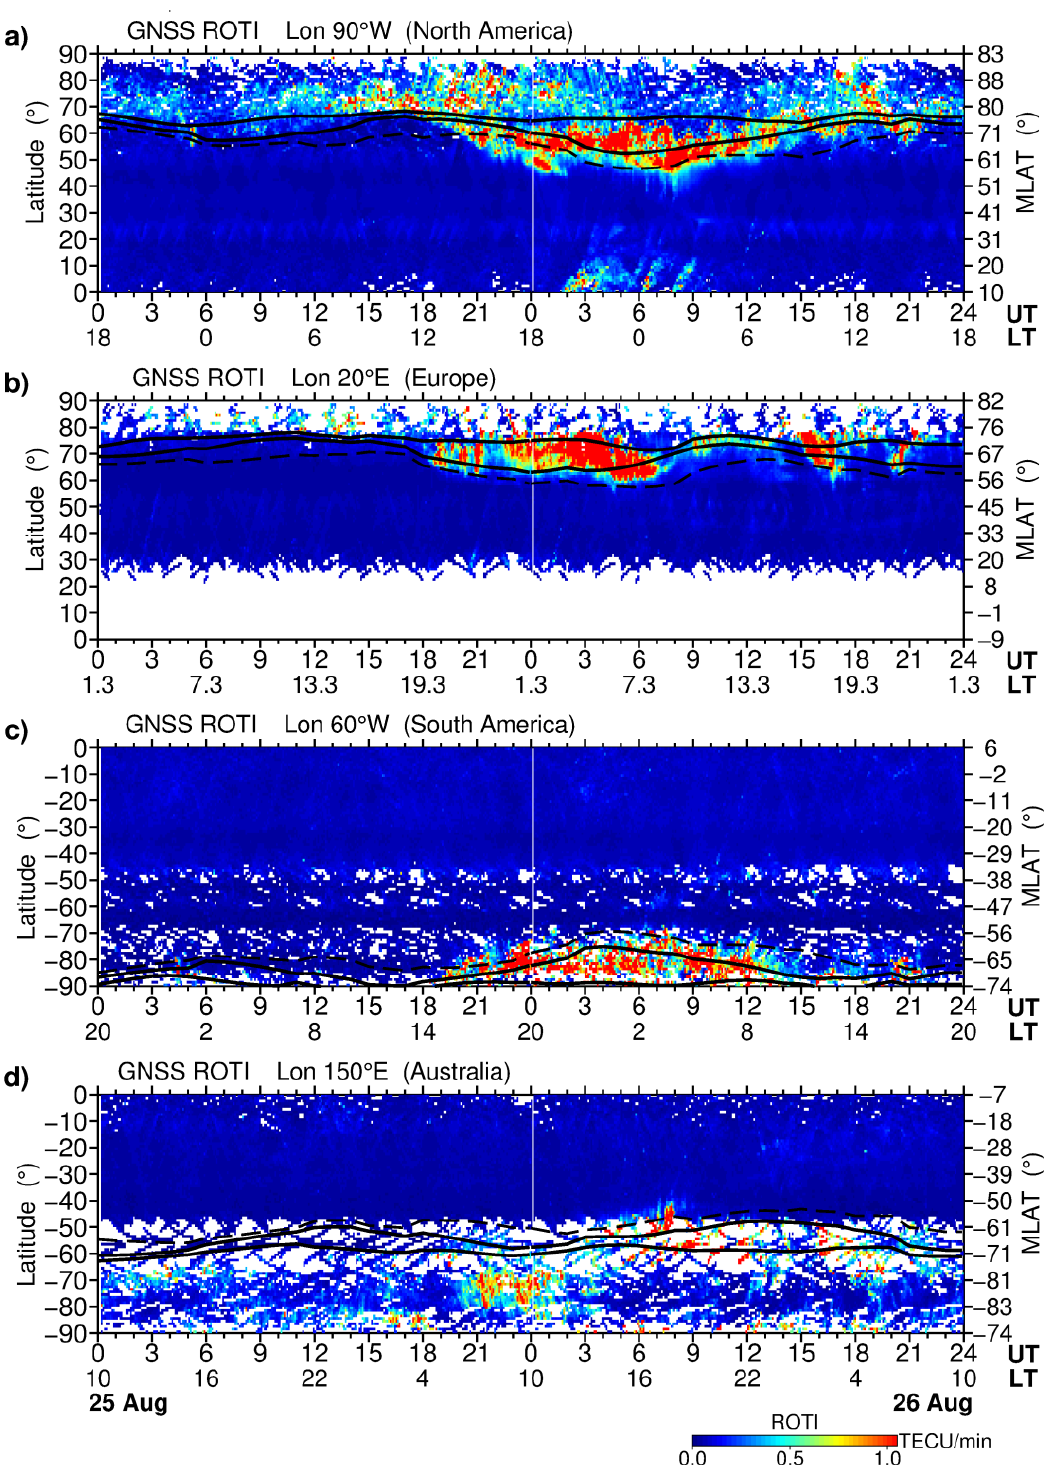
Figure 4. North–south cross-sections (keograms) representing the spatio-temporal features of the storm-induced ionospheric irregularities as detected in GNSS ROTI along ( a ) 90° W, ( b ) 20° E, ( c ) 60° W, and ( d ) 150° E longitudes in the Northern and Southern Hemispheres during 25–26 August 2018. Vertical axes show (left) geographic and (right) geomagnetic latitudes, horizontal—UT and LT time. White color depicts empty cells due to lack of actual observations. The auroral oval boundaries predicted by the Feldstein–Starkov model are marked by the black solid lines for the poleward and equatorward boundaries, and by a dashed line for the diffuse boundary.